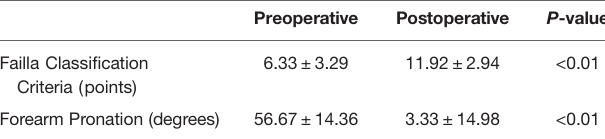
TABLE 2 | Comparison of results of preoperative and postoperative data